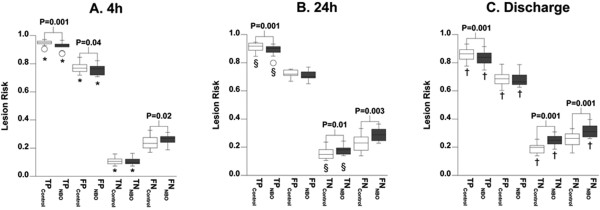
GLM-predicted risk of lesion (mean ± SD) at (A) 4 h, (B) 24 h, and (C) Discharge in areas correctly predicted to lesion by the Control-model (TPControl - white box) or by the NBO-model (TPNBO - gray box) and in areas incorrectly predicted to lesion by the Control model (FPControl - white box) or the NBO-model (FPNBO - gray box). GLM-predicted lesion risk differed significantly (P < 0.05) among the 4 regions for each of the models with the exception of FNControl and TNControl at Discharge. Differences between regions over time are also shown: *P ≤ 0.01 4 h vs. 24 h. † P < 0.001 4 h vs Discharge. §P ≤ 0.001 24 h vs Discharge.